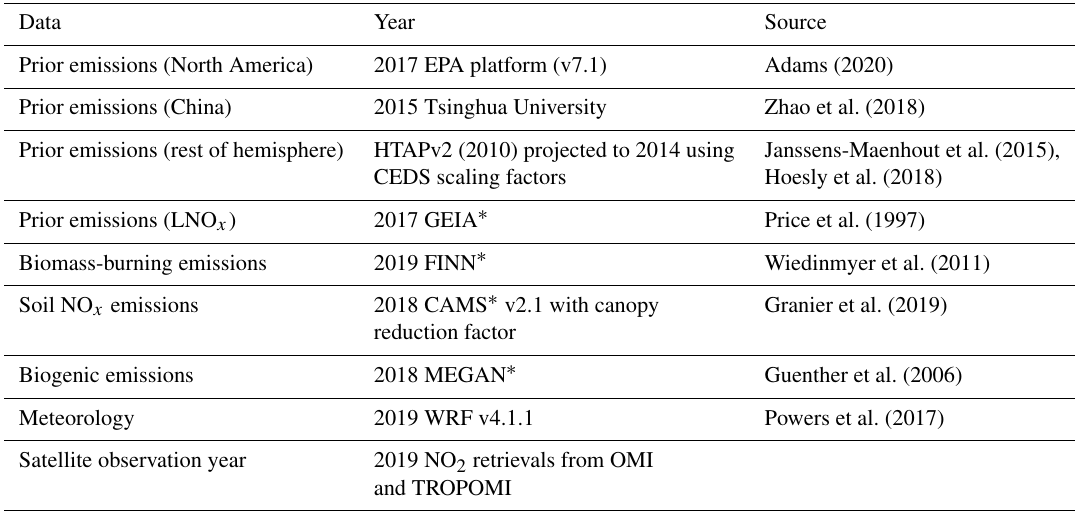
Table 1. Prior emissions and model